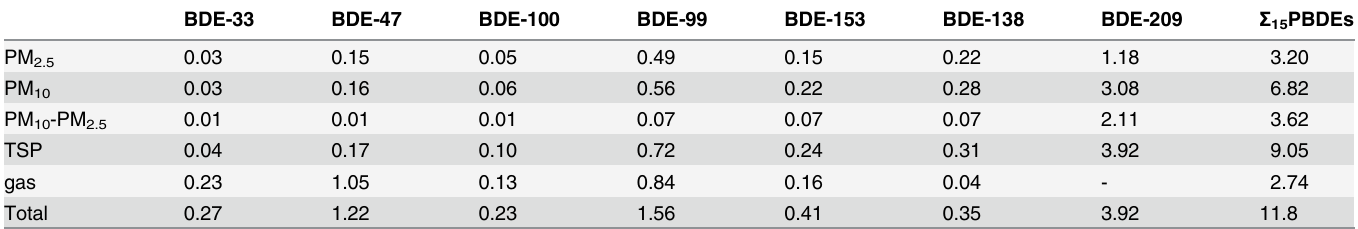
Table 3. Exposures of BDEs of PM-bound and gas-phase via inhalation (pg/kg/d).